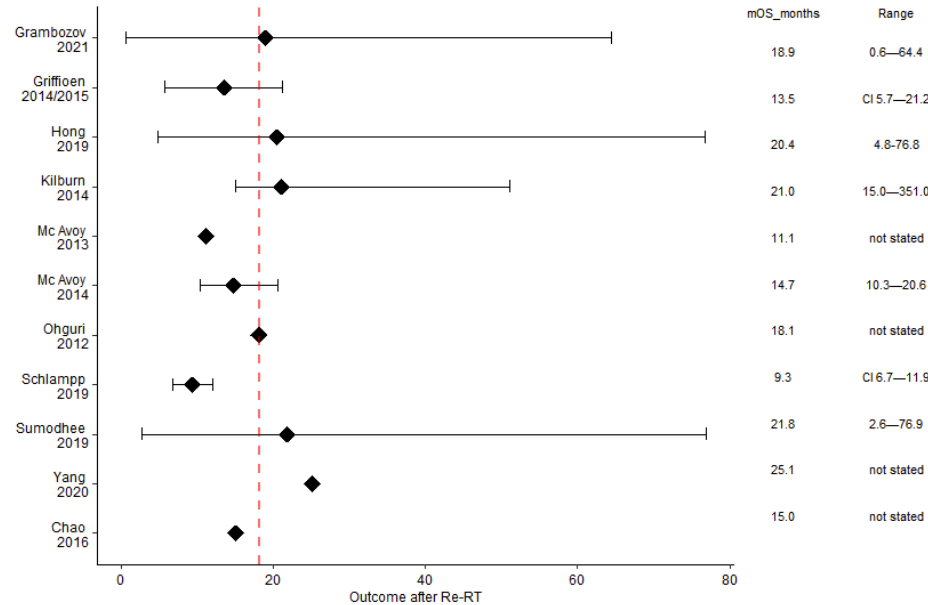
Figure 2. The median overall survival was 18.1 months (dashed red line). Although most studies presented the range, a 95% confidence interval was given only in two analyses. The black squares indicate the median OS (mOS).